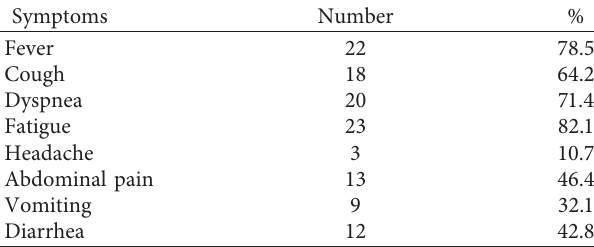
Table 2: Clinical presentation of group A.